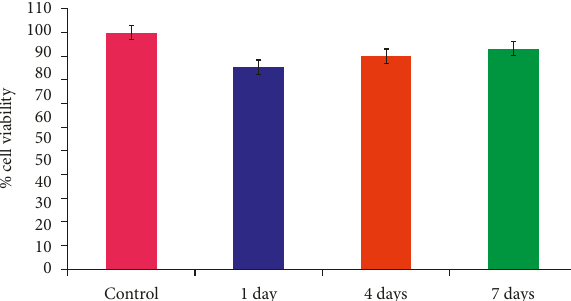
Figure 7: Bar diagram of HOS MG63 cells on HNT-CS-MHA composite coating for (a) control and (b) 1, (c) 4, and (d) 7 days of incubation.